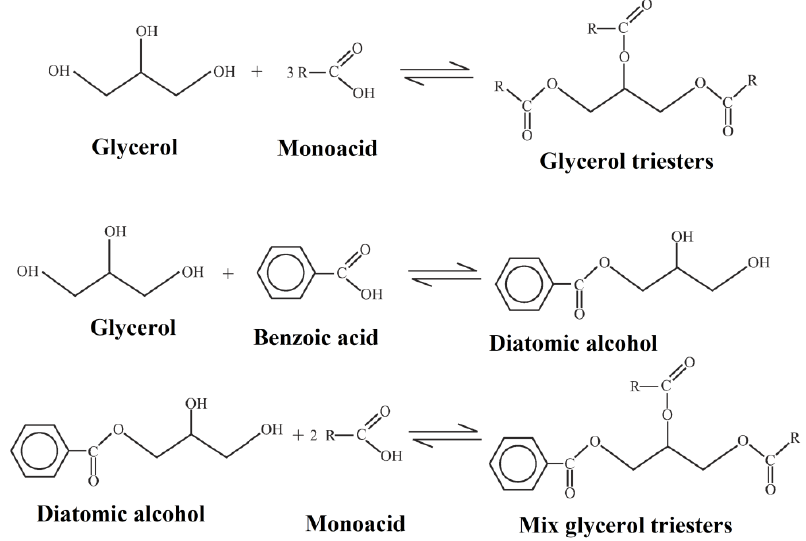
Figure 19. Synthesis of glycerol triesters and mix glycerol triesters.